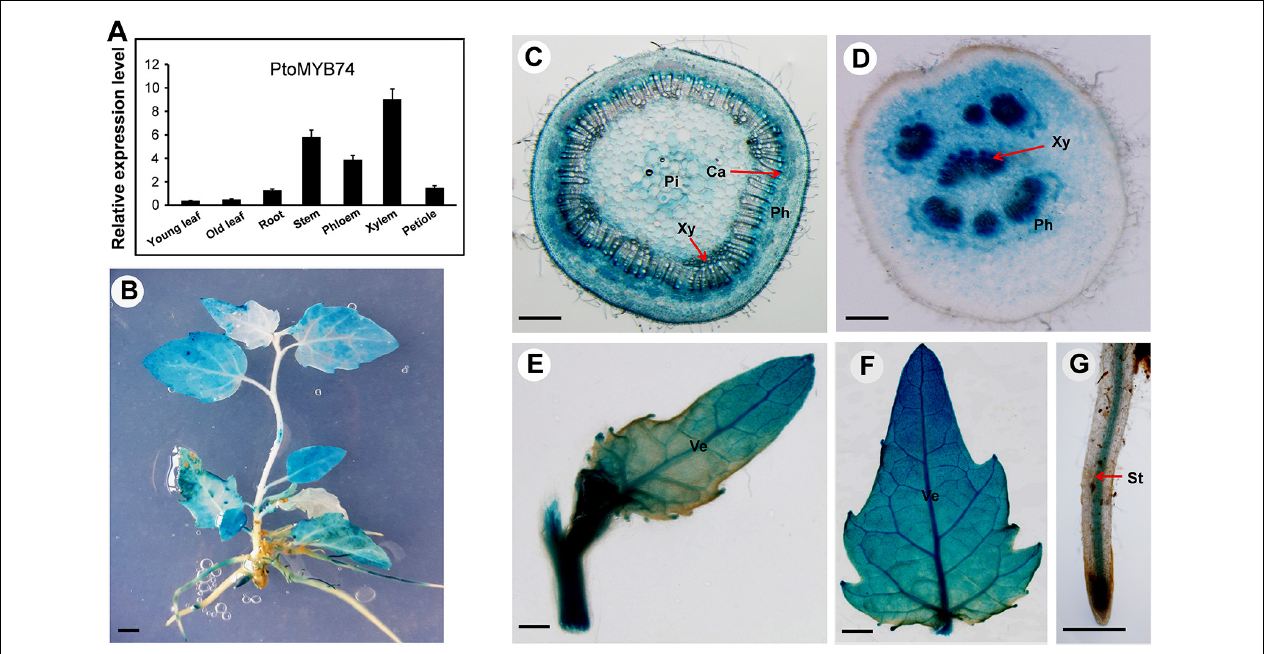
FIGURE 2 | Express patterns of PtoMYB74 in vascular blade, tissues, and organs of poplar. (A) RT-qPCR analysis of the relative expression levels of PtoMYB74 in seven different tissues of wild-type poplar. The poplar 18S rRNA was used as an internal reference. Error bars represent ± SD from three biological repeats. (B–F) The PtoMYB74 gene promoter-driven GUS expression vector was introduced into P. tomentosa Carr. The GUS expression was detected in seedlings (B) and various tissues of PtoMYB74:GUS plants, including the stem (C) , petiole (D) , young leaf (E) , old leaf (F) , and root (G) . Ca, cambium; Ph, phloem; Pi, pith; St, stele; Ve, vein; Xy, xylem. The red arrow indicates the different tissues of poplar. Bars: B = 5 mm; C,D = 500 mm; E,F = 2 mm; G = 100